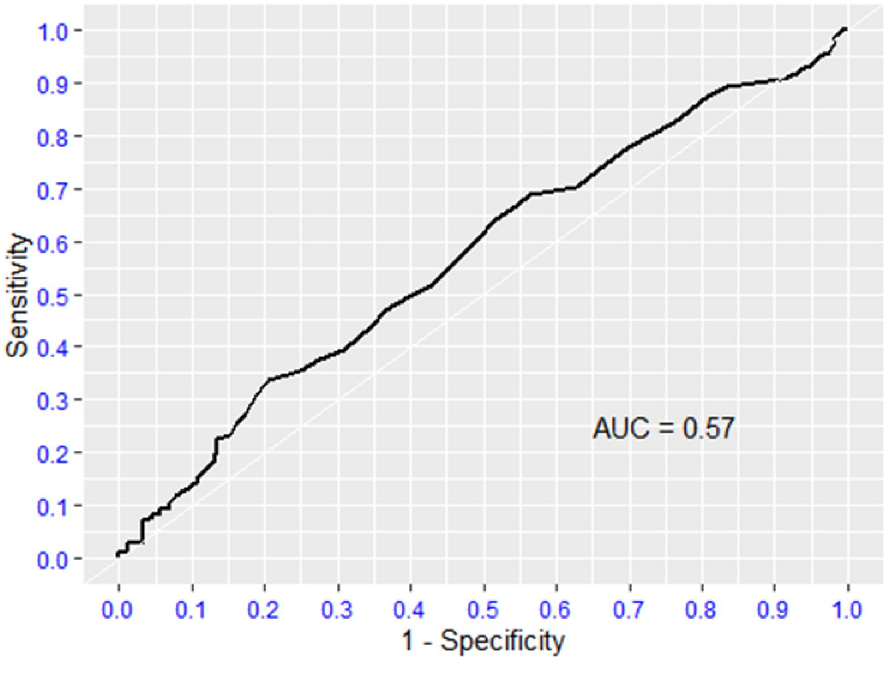
Fig 3. ROC curve INR.